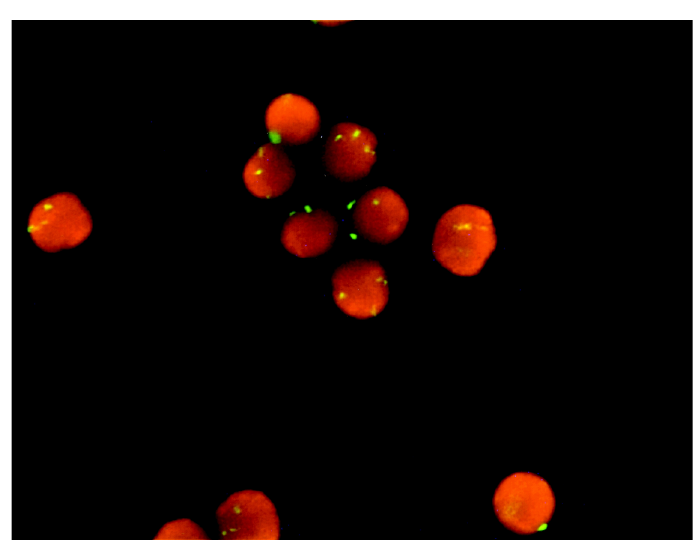
Figure 1 - FISH of case 11. The interphase cells present 3 fluorescent signals.